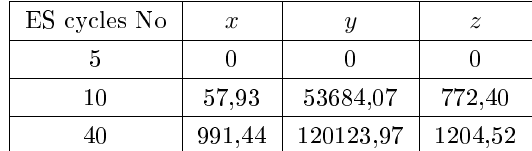
Fig. 6: Computing time of whole GPA-ES for x variable depending on ES cycle limit and ES population size.